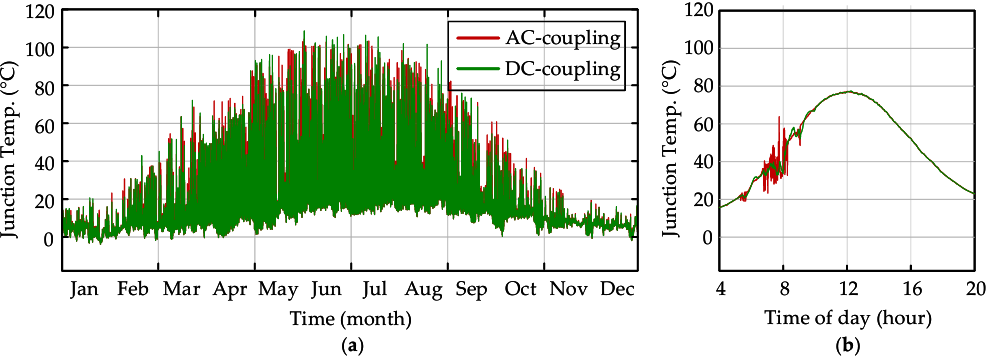
Figure 8. Junction temperature of the IGBT T1 (see Figure 4) in the PV inverter integrated with the AC- or DC-coupled BESS: ( a ) one-year operation and ( b ) one-day operation.